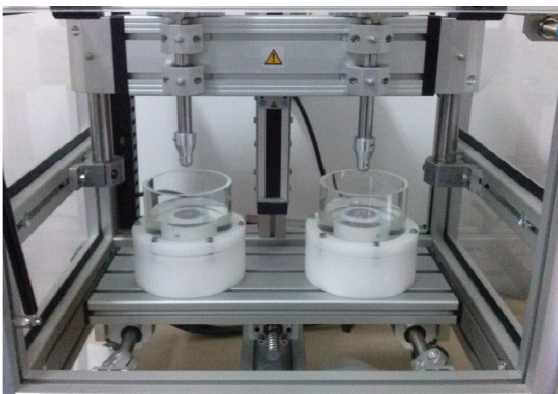
Figure 1. Dual-axis chewing simulator (CS-4.2, SD Mechatronik, Germany).